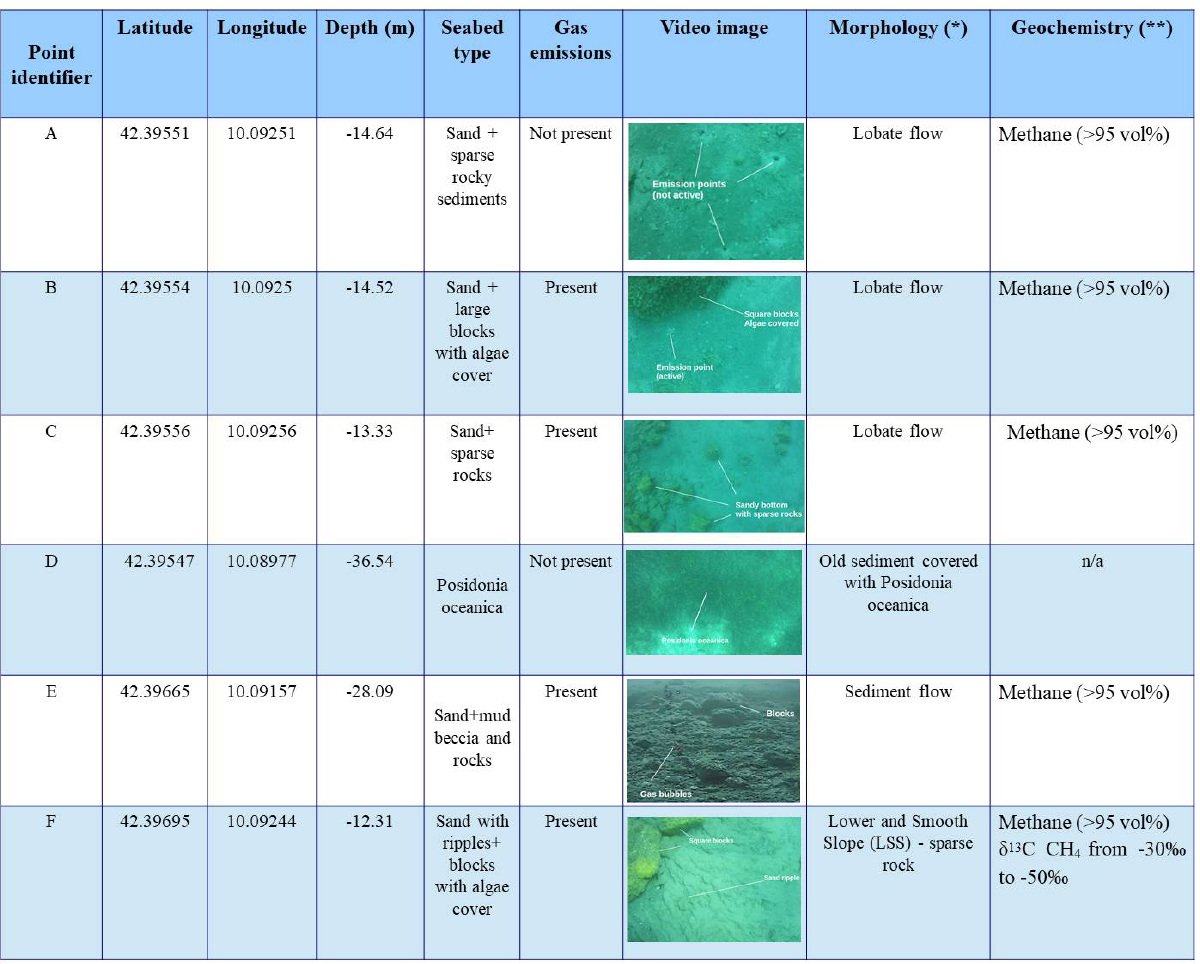
Table 2. Table showing details about the selected point of Figure 11: position coordinates (WGS84-EPSG 4326), depth of the seabed (m), seabed type, presence or not of gas emission, and the image of the area extracted from the video. * = morphology data as indicated in [40]; ** = geochemistry data as indicated in